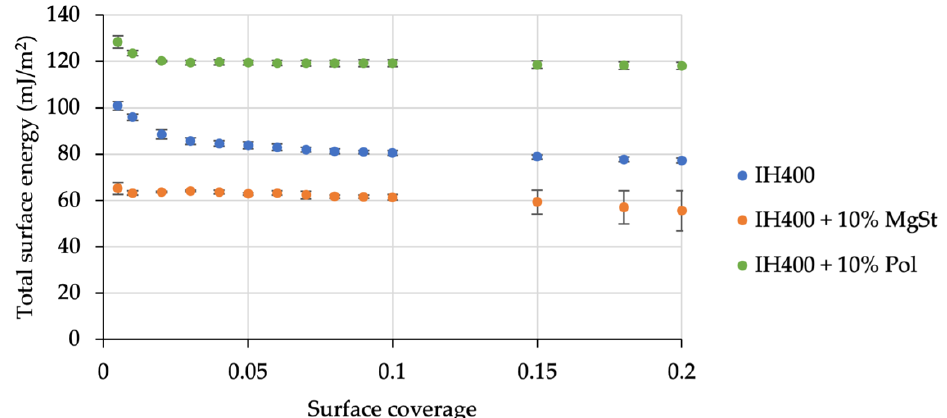
Figure 6. Distribution of total surface energies of fines engineered by co-milling. n = 3, error bars denote standard deviation.